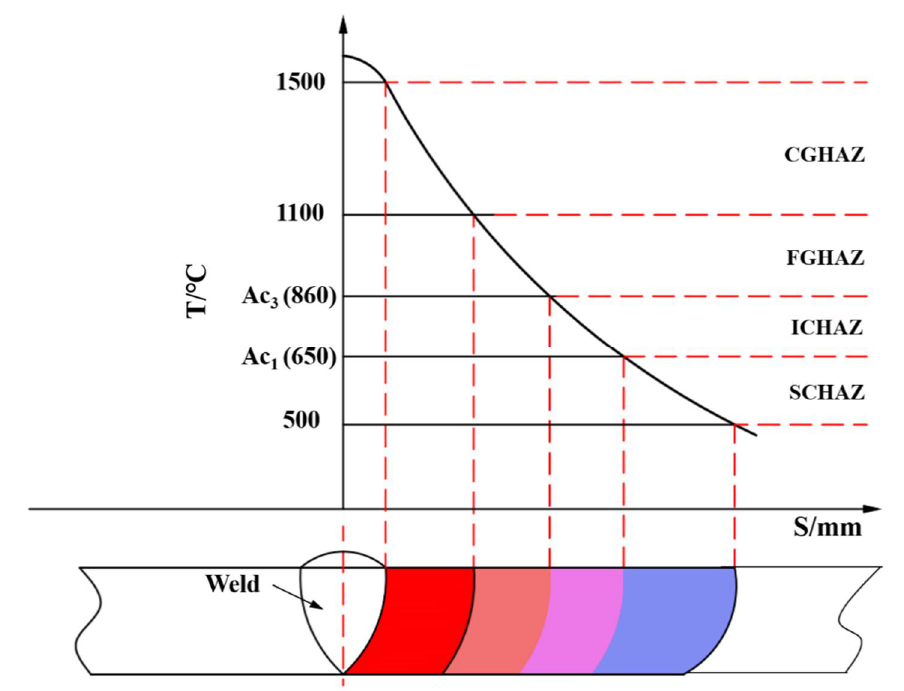
Figure 3. Diagram of microstructure distribution in welding heat-affected zone.